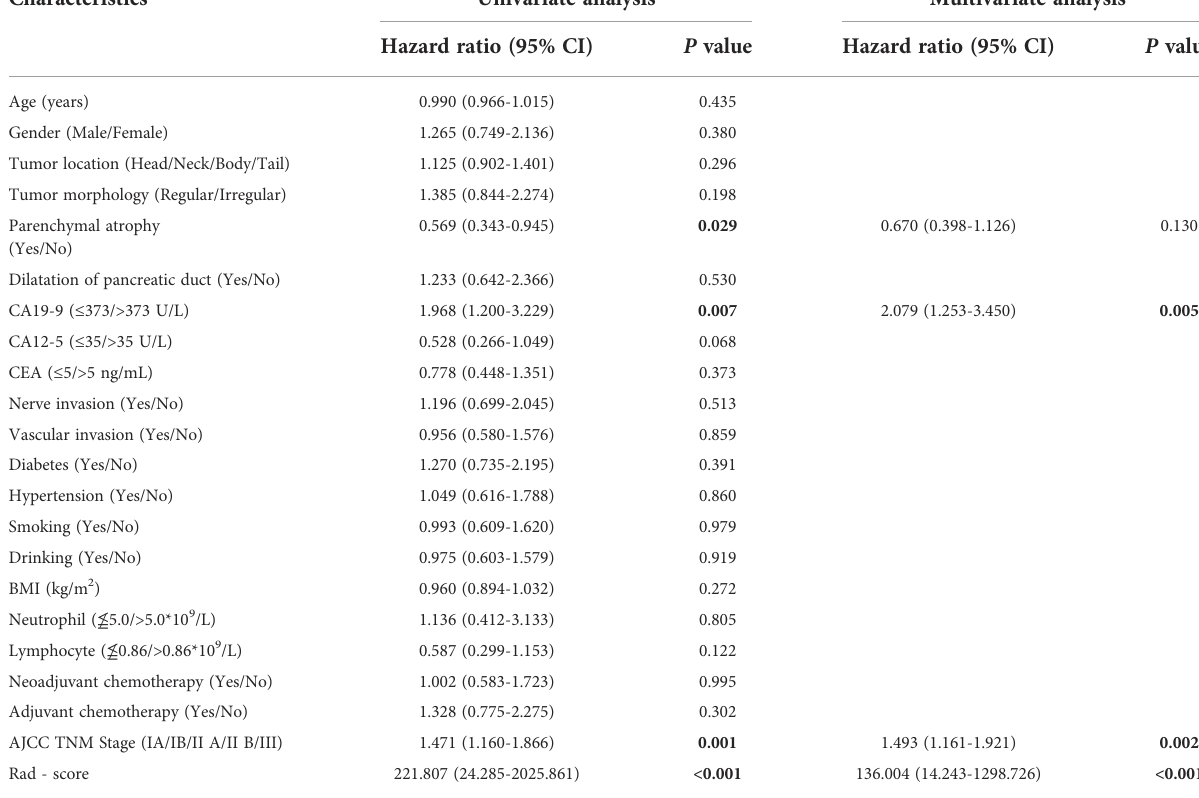
TABLE 3 Univariate and Multivariate Cox Regression Analysis of the clinical parameters.